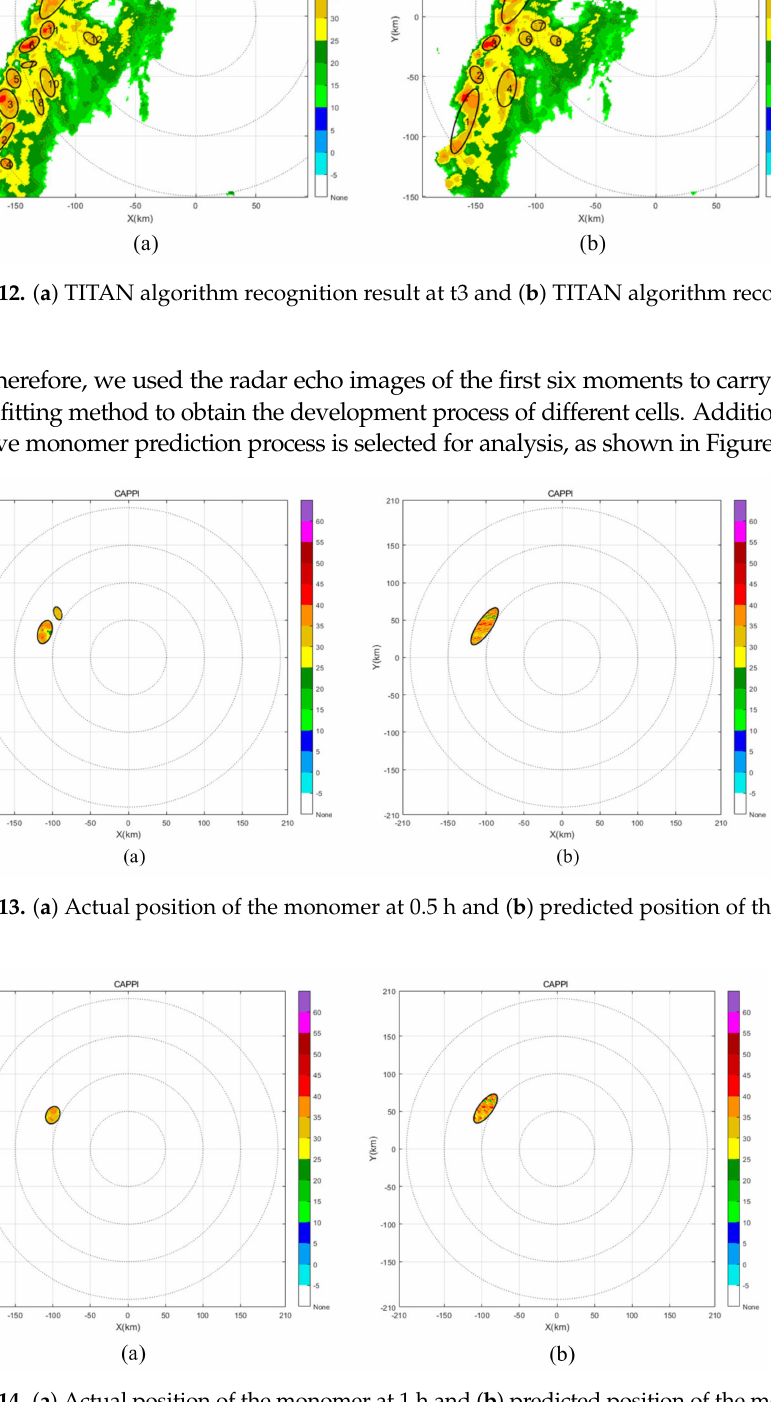
Figure 14. ( a ) Actual position of the monomer at 1 h and ( b ) predicted position of the monomer at 1